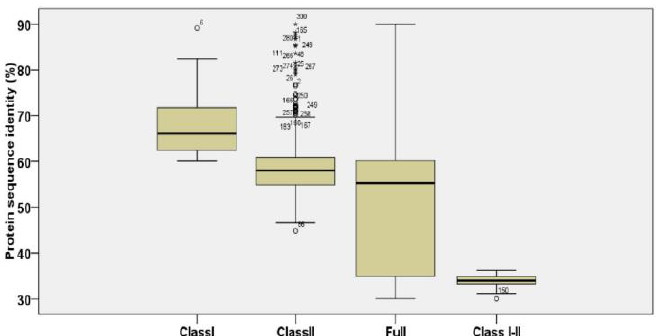
Figure 3. Pairwise protein sequence identity of ScTPS proteins. ClassI, ClassII, Full and Class I-II represent the protein sequence identities in Class I TPS proteins group, Class II TPS proteins group, full TPS proteins group and sequence identities between Class I and Class II TPS proteins. Outliers and extreme outside of the boxplot whiskers (labeled by data number) are shown as circles and asterisks, respectively.